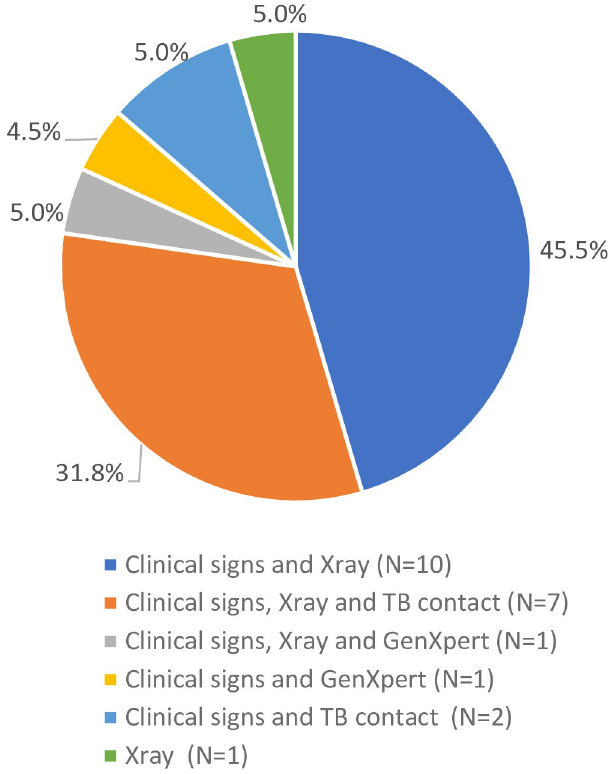
Fig 1. Diagnostic characteristics of 22 children started on TB treatment.